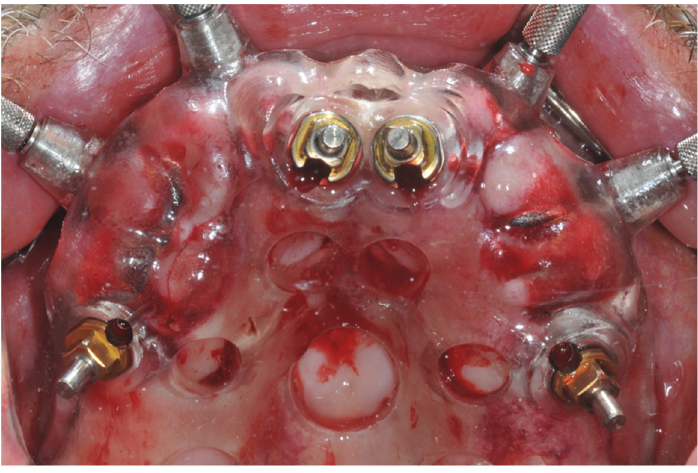
Figure 4. Implants inserted through the second surgical stent. Alveolar socket preservation with deproteinized bovine bone mineral particles